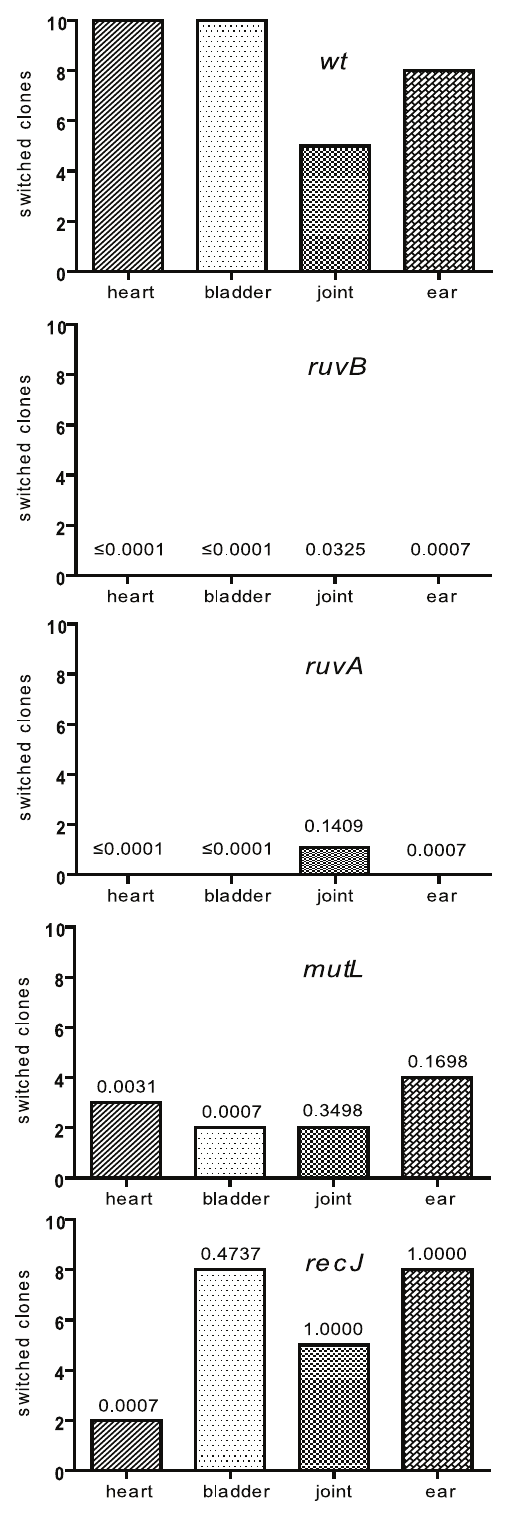
Figure 3. Number of switched vlsE clones in SCID C3H/HeN mice. Sequencing of the cloned PCR product of the vlsE variable regions using primer pJET1.2/forward was performed on 10 clones from each tissue type culture for each genotype (see Materials and Methods). The y-axis denotes the number of clones out of ten that contained templated nucleotide changes in variable regions 1–6 (switches) and the x-axis denotes the tissue type. The